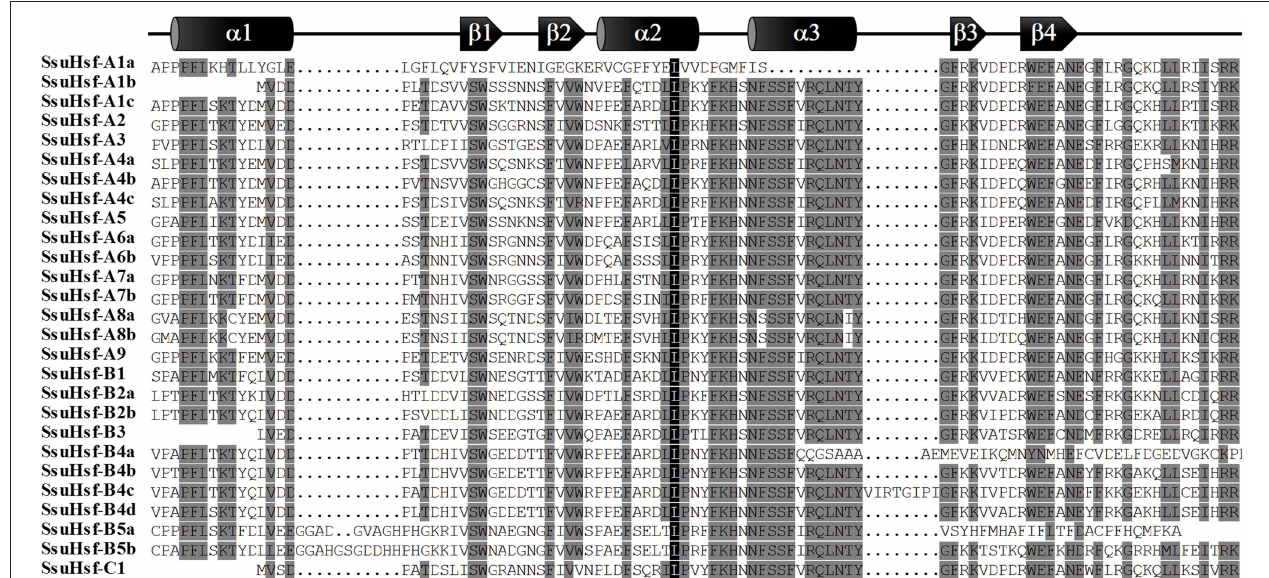
FIGURE 4 | Multiple sequence alignment of the DBD domains of the SsuHsf proteins. The secondary structures of the DBD ( α 1- β 1- β 2- α 2- α 3- β 3- β 4) are shown above the alignment. α -helices and β -sheets were marked using cylindrical tubes and block arrows,